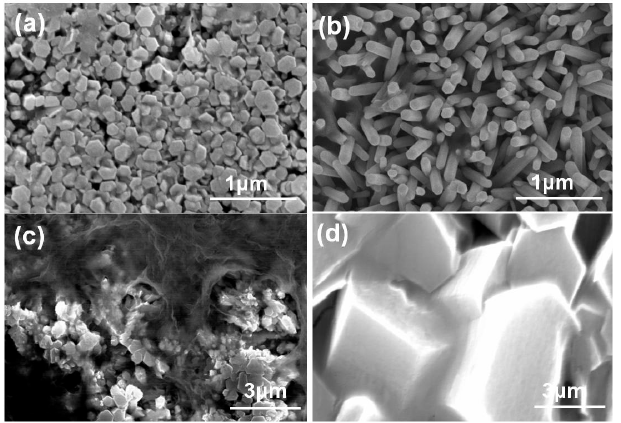
Figure 1. Surface morphologies of hydrothermally grown Eu 3+ -doped ZnO nanostructures, ( a ) undoped ZnO synthesized at 80 °C; synthesized at 100 °C: ( b ) undoped ZnO, ( c ) ZnO-20-Eu, and ( d ) ZnO-40-Eu.